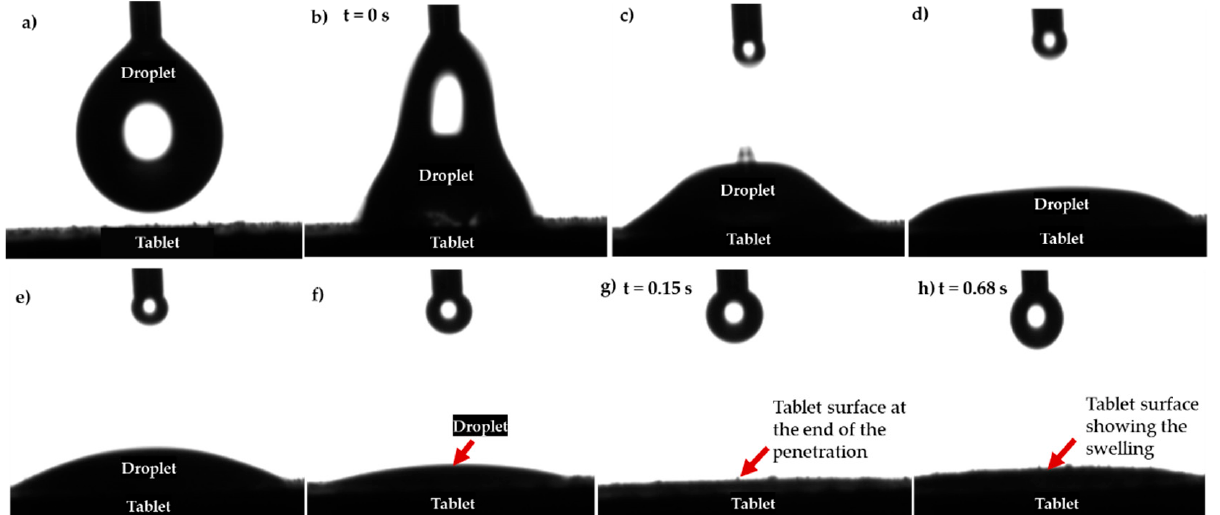
Figure 6. Series of images showing ( a ) the water droplet at the tip of the needle and the tablet surface, ( b ) the contact between the surface and the droplet, ( c ) the beginning of the penetration, ( d – f ) the intermediate stage of the penetration, ( g ) the end of the penetration, and ( h ) the swelling of the particle after the penetration. The tablet was compressed at 20 MPa.